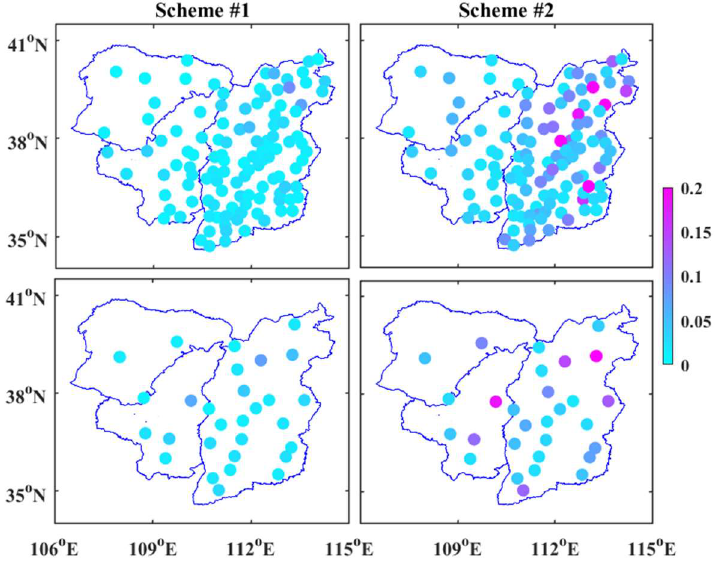
Figure 6. Map showing the CRE at each site for the two schemes in the internal and external accuracy tests.